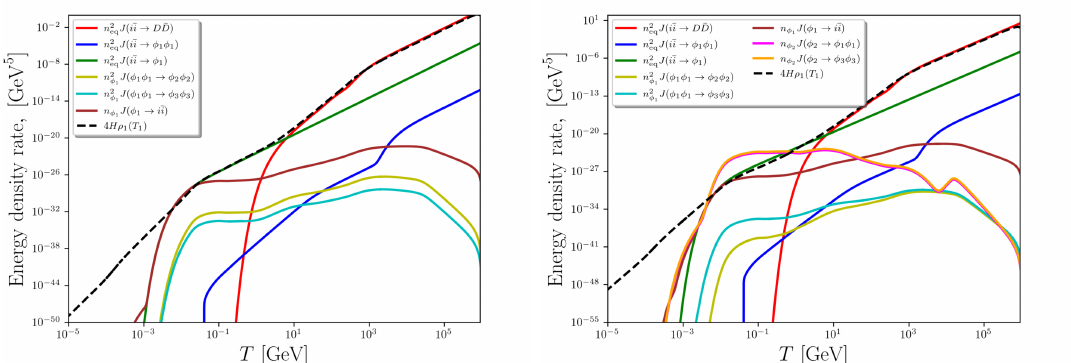
Figure 3. Plots of the energy exchange rate between different sectors versus the visible sector temperature T . The input for the left panel (Case 1) are same as in figure 2 while the input for the right panel (Case 2) are the same as in figure 5.